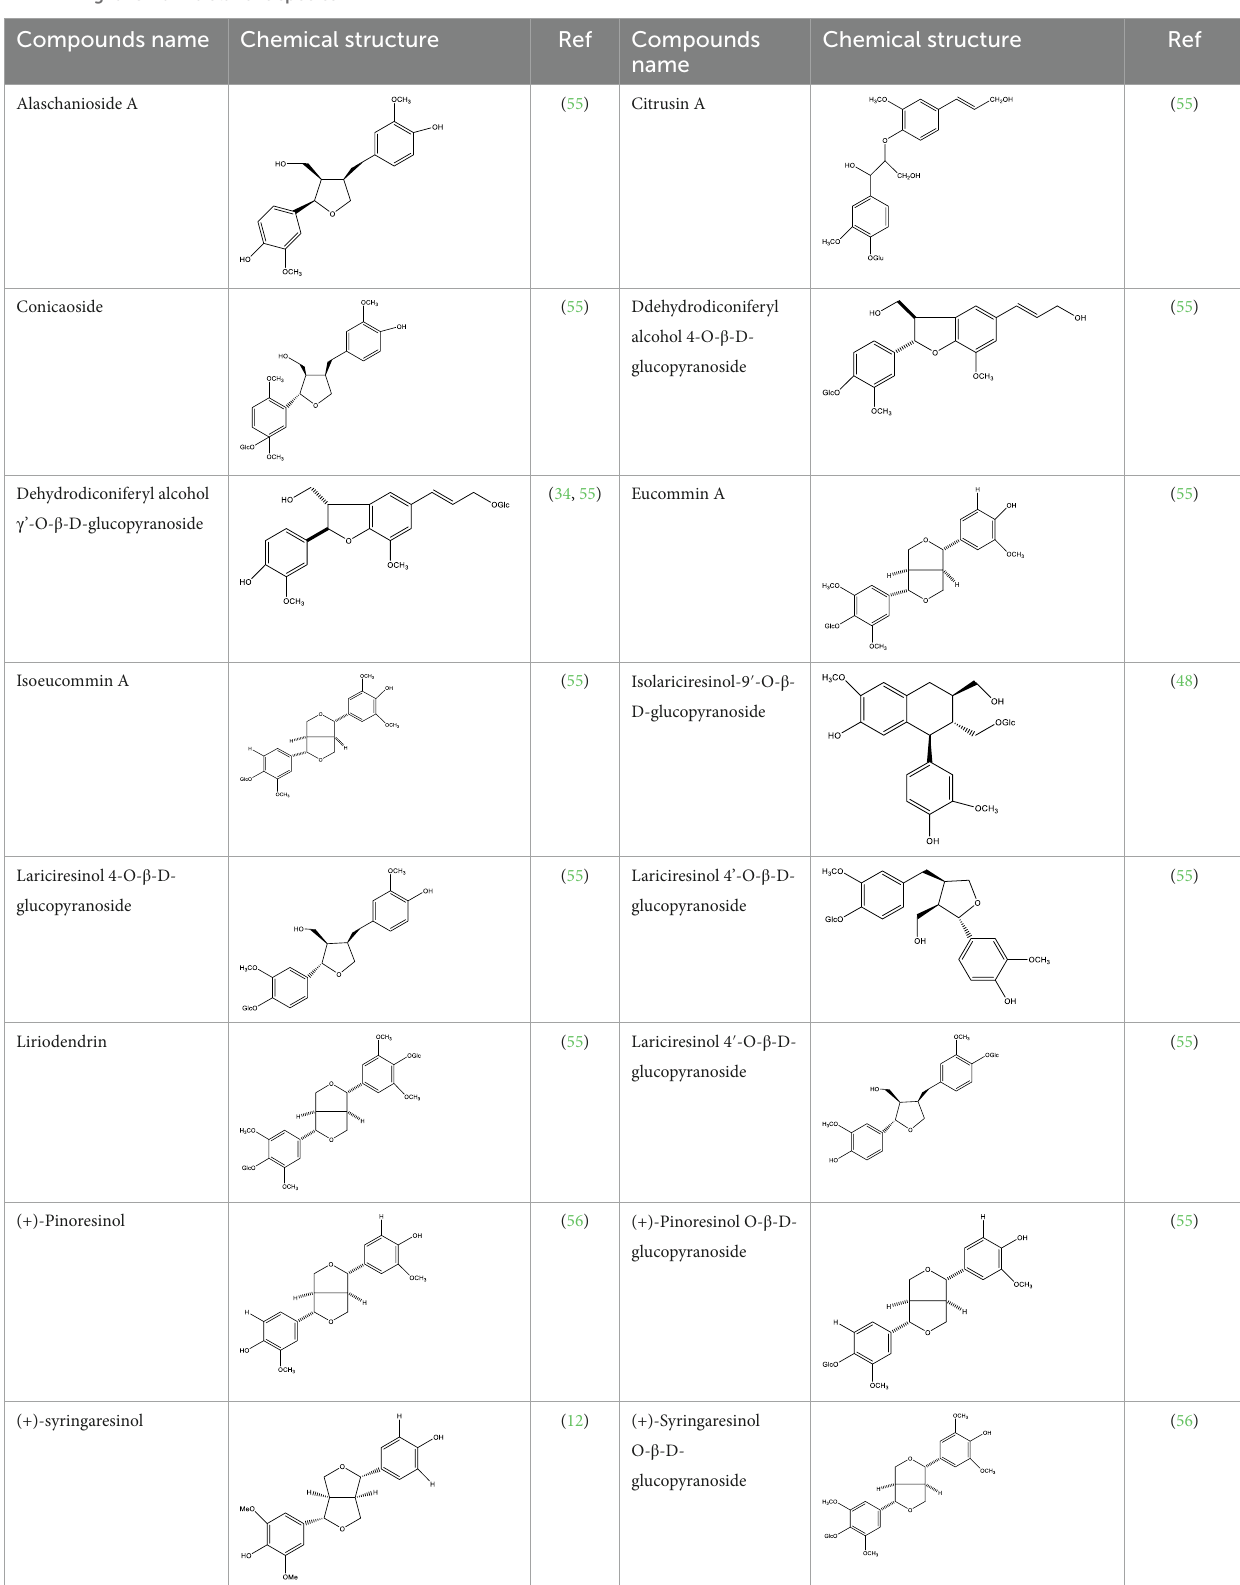
TABLE 4 Lignans from Cistanche